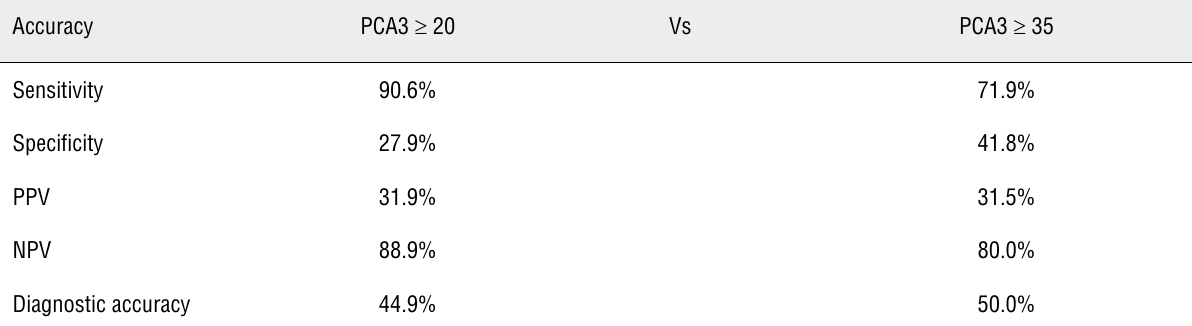
Table 1 - PcA3 score accuracy in diagnosing prostate cancer: cut-off 20 vs 35.